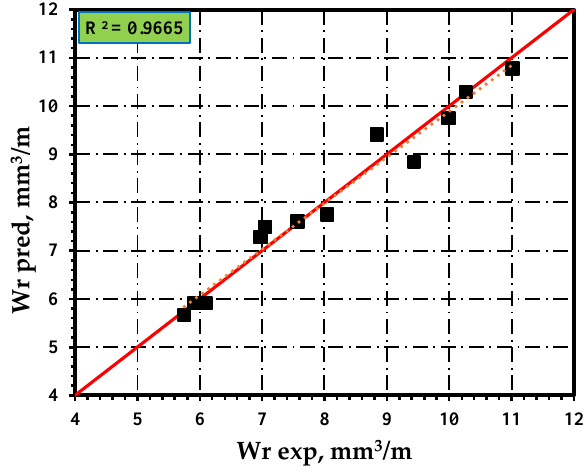
Figure 11. SRM-predicted wear rate versus experimental results.